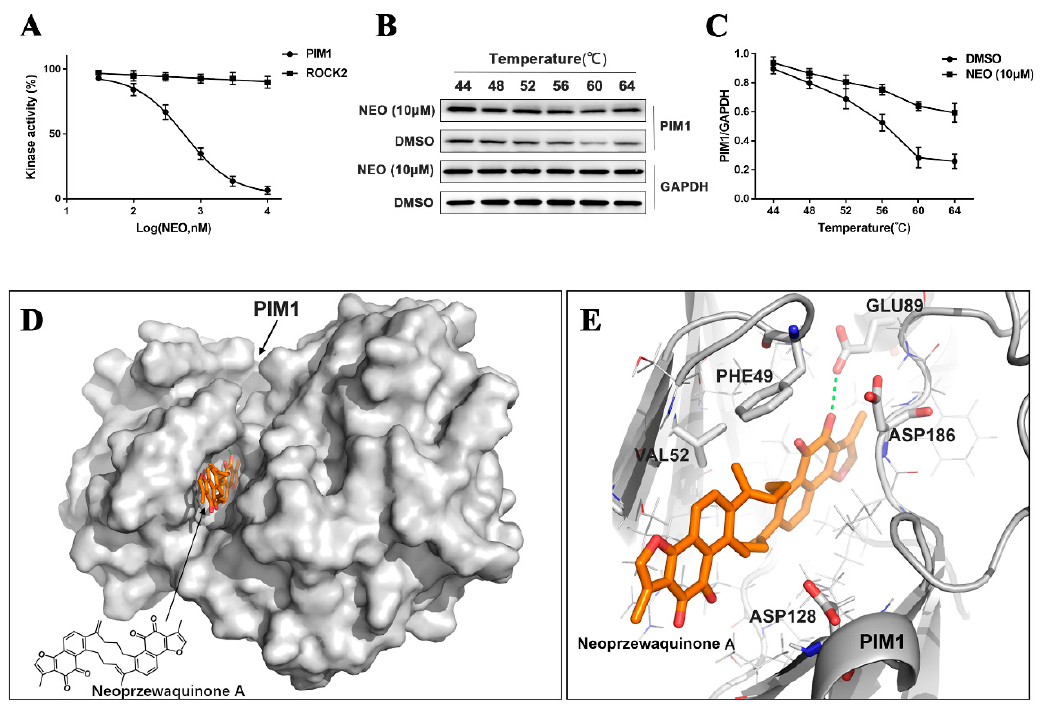
Figure 3. PIM1 is the potential target of NEO. ( A ) Inhibitory effects of NEO on PIM1 and ROCK2 kinase. ( B , C ) CETSA-WB assay to confirm that NEO targeted PIM1 proteins. ( D ) Three-dimensional structure of the PIM1 receptor and NEO ligand. ( E ) The protein backbone of PIM1 receptor is presented as a cartoon. Each value is the mean ± SD for n = 3.